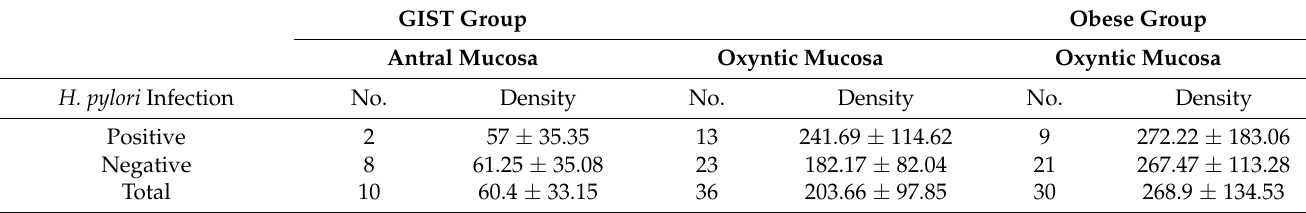
Table 3. Mean density of GhrC (cells/10HPF) and H. pylori infection in gastric mucosa of patients with GIST and obese patients. GIST Group Obese Group Antral Mucosa Oxyntic Mucosa Oxyntic Mucosa H. pylori